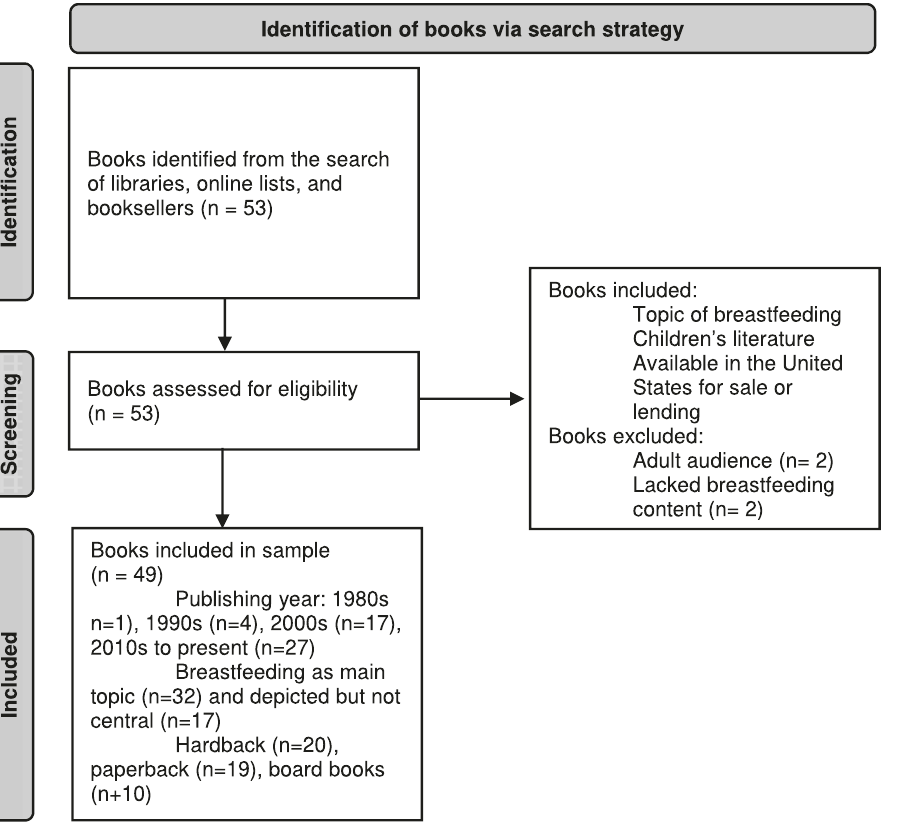
Adapted from Page et al.